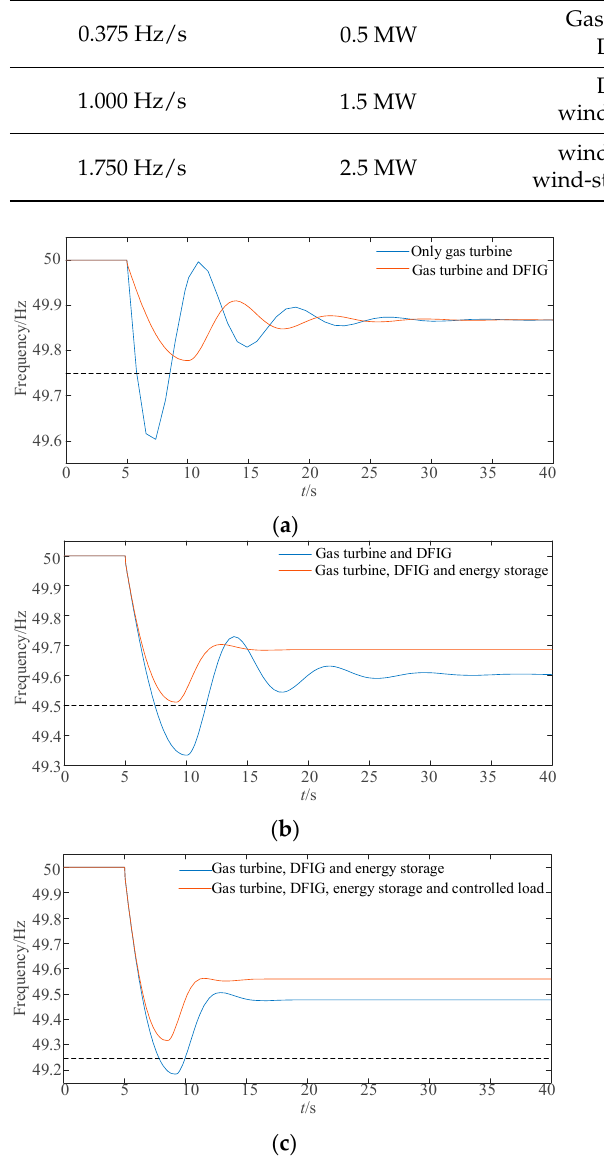
Figure 8. The results of the system frequency response under different load disturbances. ( a ) Fre- quency change diagram when the load increases by 0.5 MW; ( b ) Frequency change diagram when the load increases by 1.5 MW; ( c ) Frequency change diagram when the load increases by 2.5 MW.